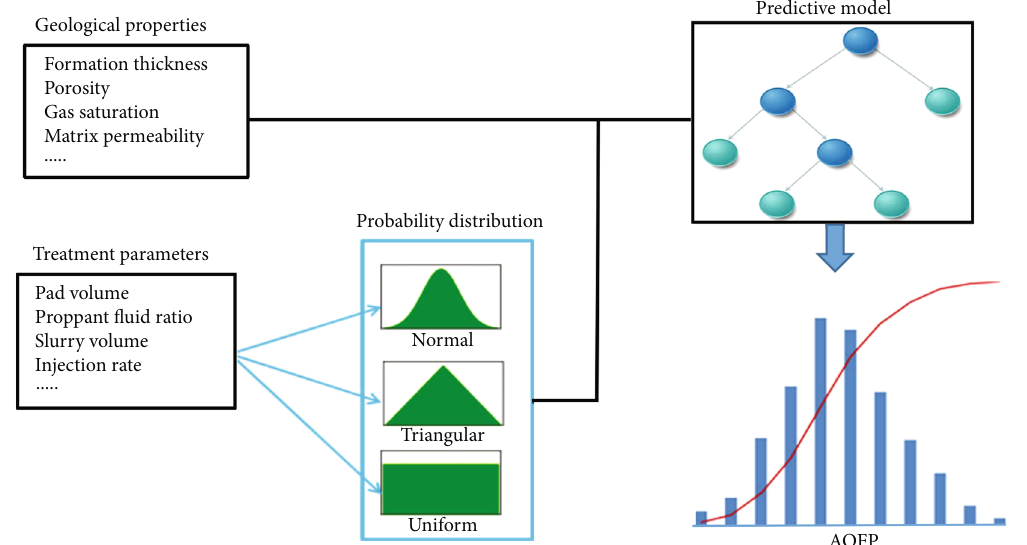
Figure 2: Probabilistic evaluation of a fractured well through obtaining cumulative probability distribution of AOFP (modi fi ed from [23])